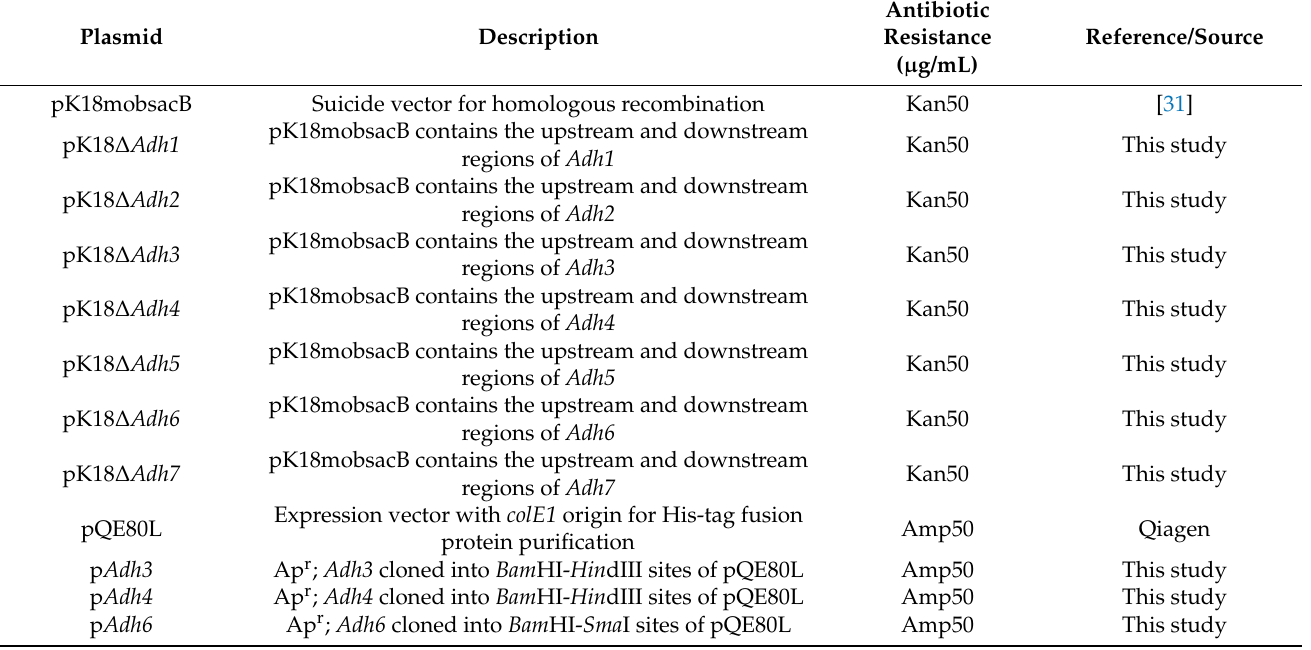
Table 3. Plasmids and bacterial strains used in this